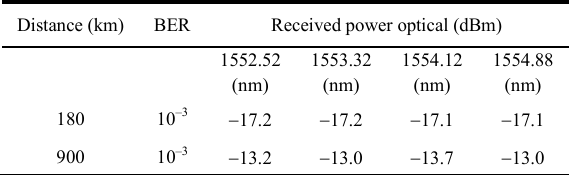
Table 2 Long haul transmission using (FEC): OSNR. Distance (km)